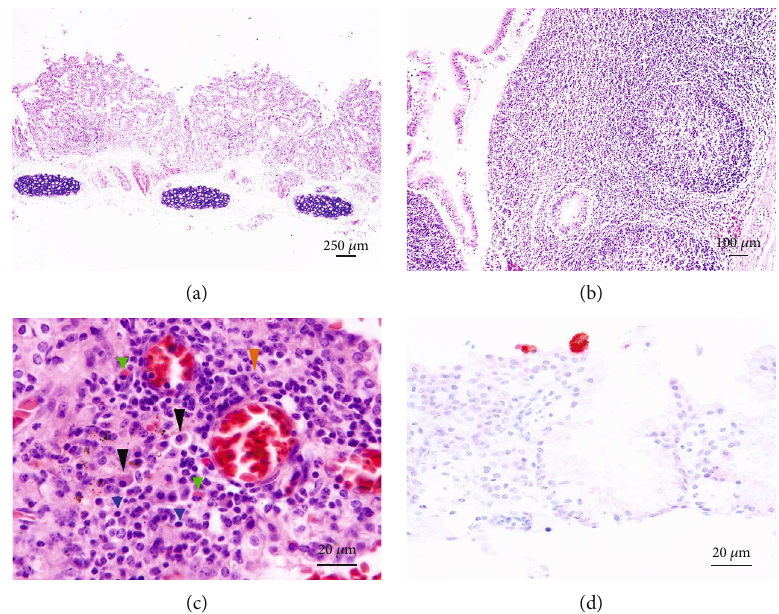
Figure 1: Histology and immunohistochemical detection of Mycoplasma spp. in domestic pigeons. (a) Trachea (H&E); marked epithelial hyperplasia and increased cellularity of the lamina propria and multifocal areas of erosion and ulceration. (b) Trachea (H&E); submucosal lymphoid aggregates. (c) Lung (H&E); mononuclear aggregates are characterized by small lymphocytes (short blue arrowhead), plasma cells (long black arrowhead), macrophages (long orange arrowhead), and occasional heterophils (short green arrowhead). (d) Trachea (IHC); Mycoplasma spp. seen as fi nely granular intracytoplasmic reaction on the respiratory